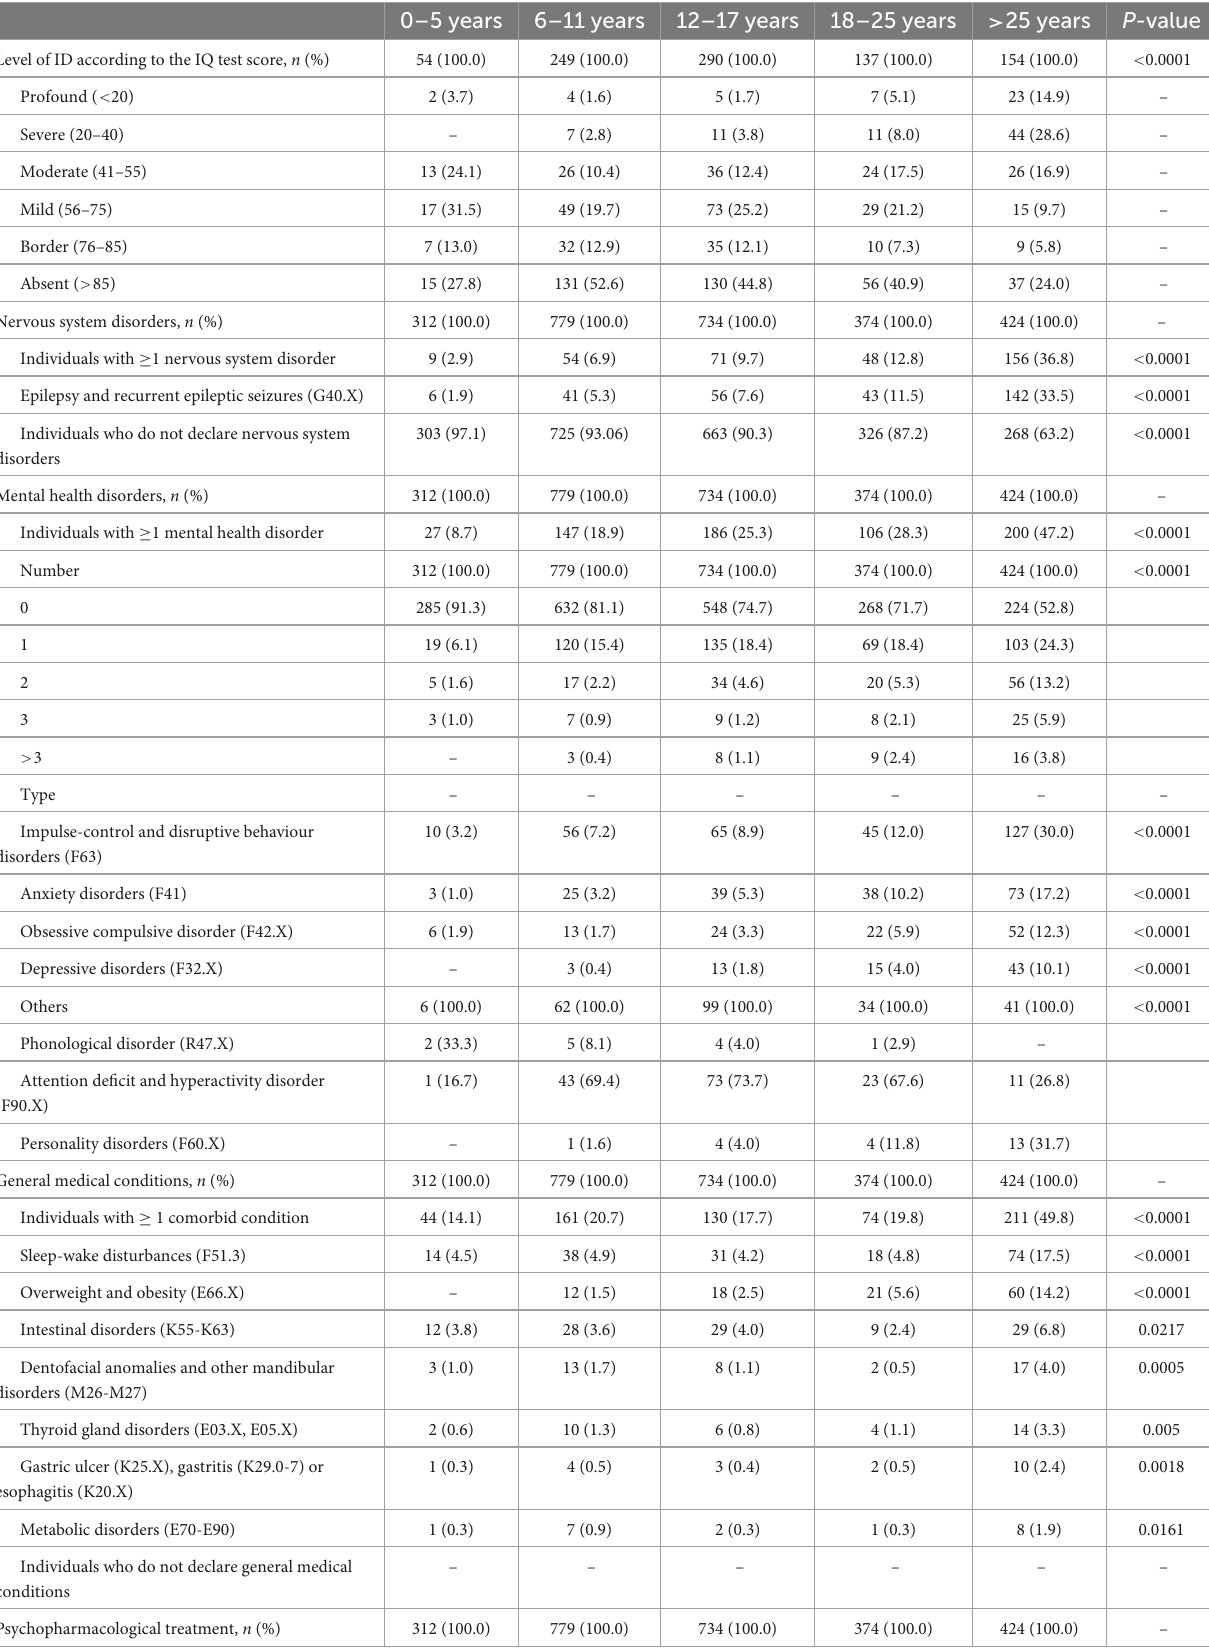
TABLE 4 Intellectual disability, nervous system, and mental health disorders, general medical conditions and psychopharmacological treatment according to age